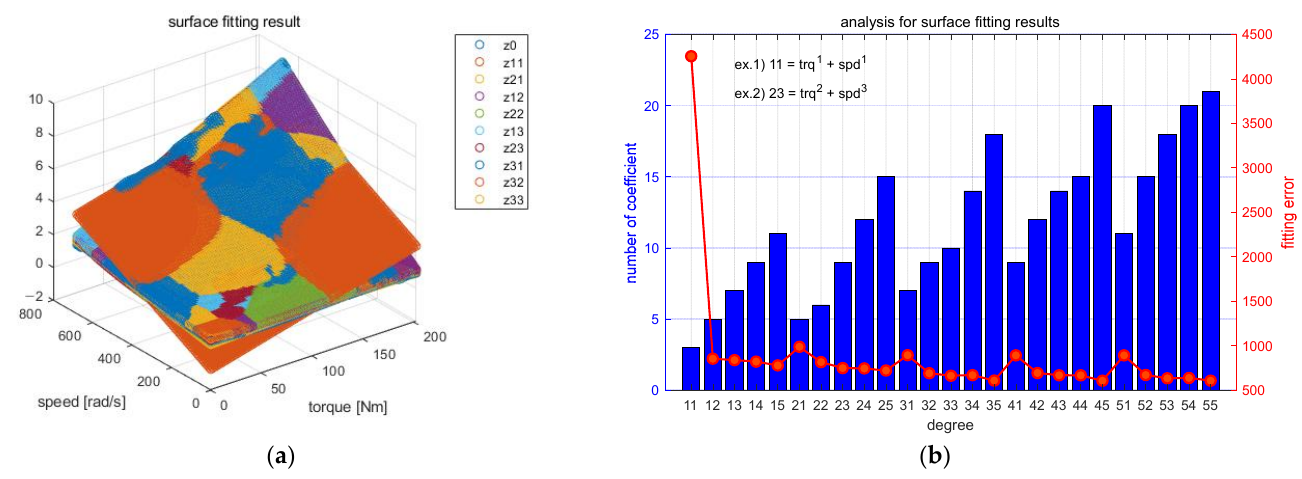
Figure 6. Surface fitting results for a fuel-consumption rate map. ( a ) surface fitting result with various degree. ( b ) Fitting error according to the degree of polynomial.